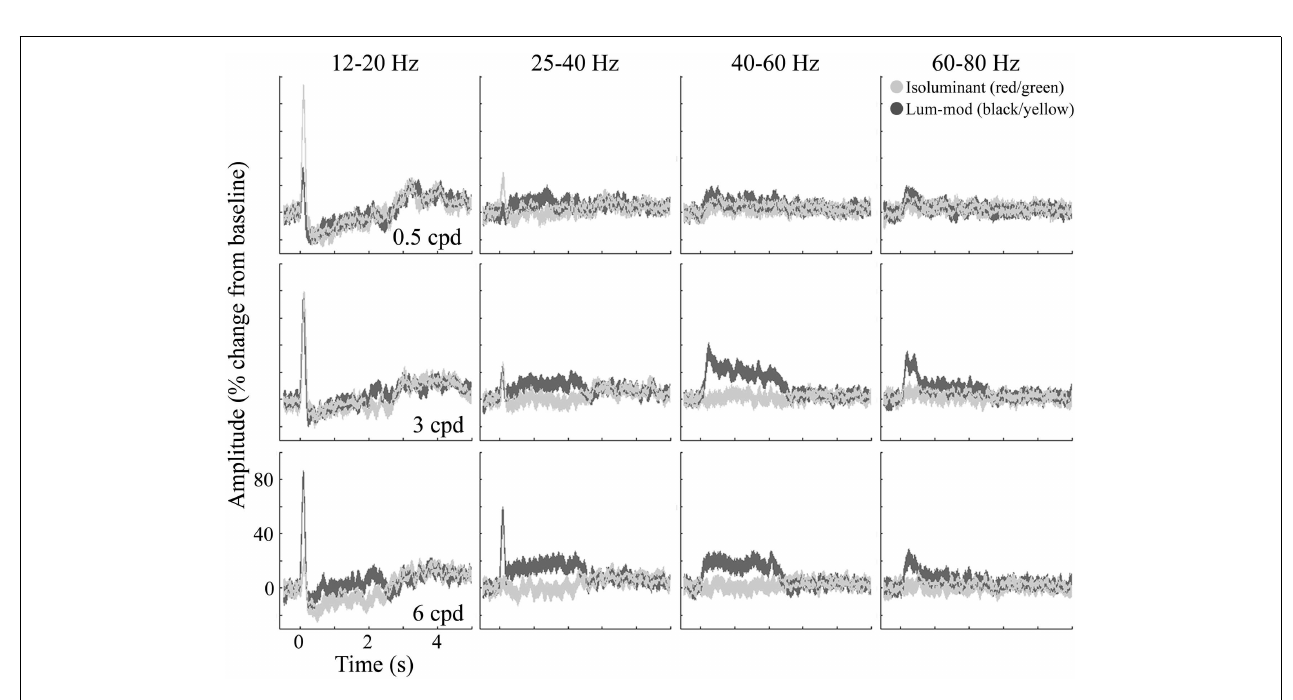
gray.The shaded regions indicate the SEM across all participants.The amplitude spectra, plotted as percentage change from the pre-stimulus baseline, are shown for each of the stimulus spatial frequencies and for a range of frequency bands chosen to illustrate the main effects